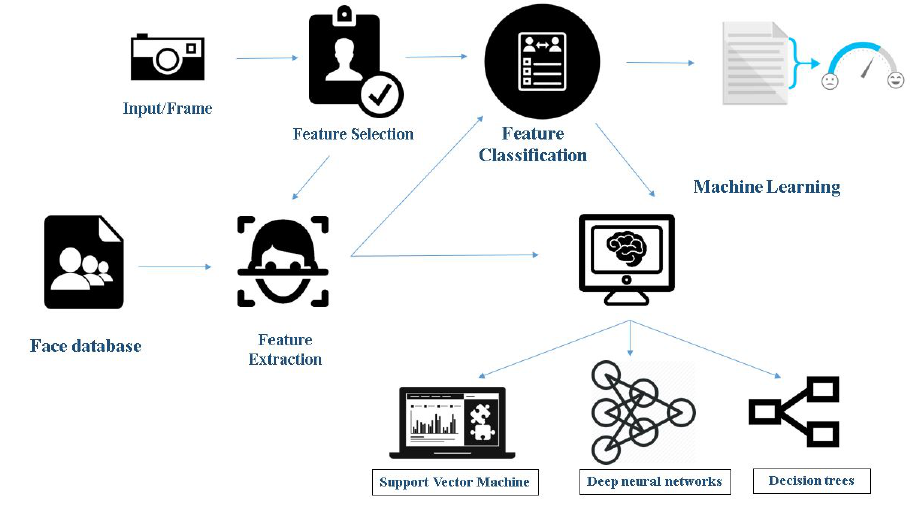
Figure 1. Face detection and emotion recognition using machine